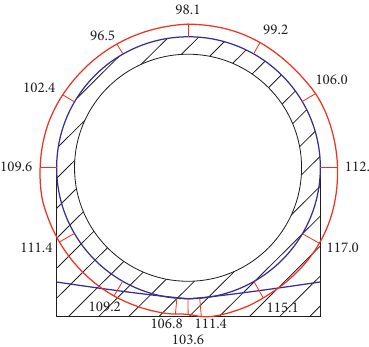
Figure 10: Water head test curve at 56 m in the water pressure test of the magnetic fluxsensor after soil filling